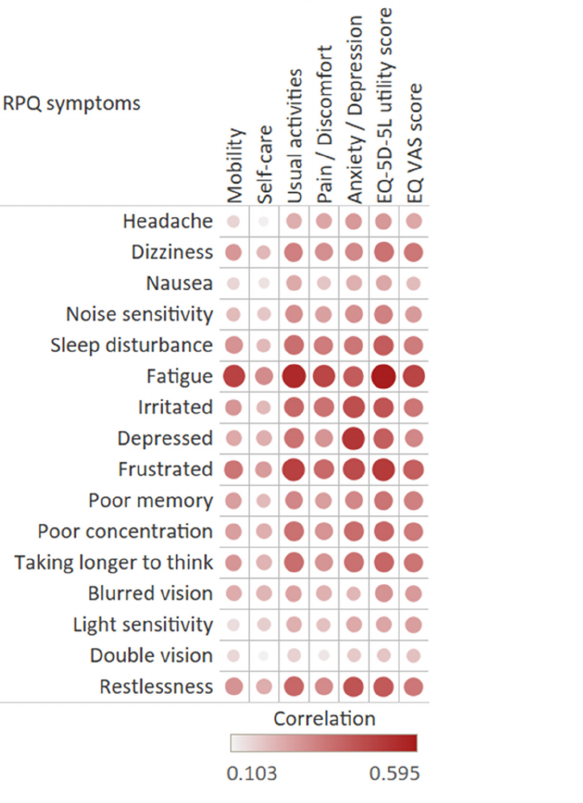
Figure 4. Correlation of RPQ items and EQ-5D-5L dimensions and EQ-5D-5L utility and EQ VAS scores.